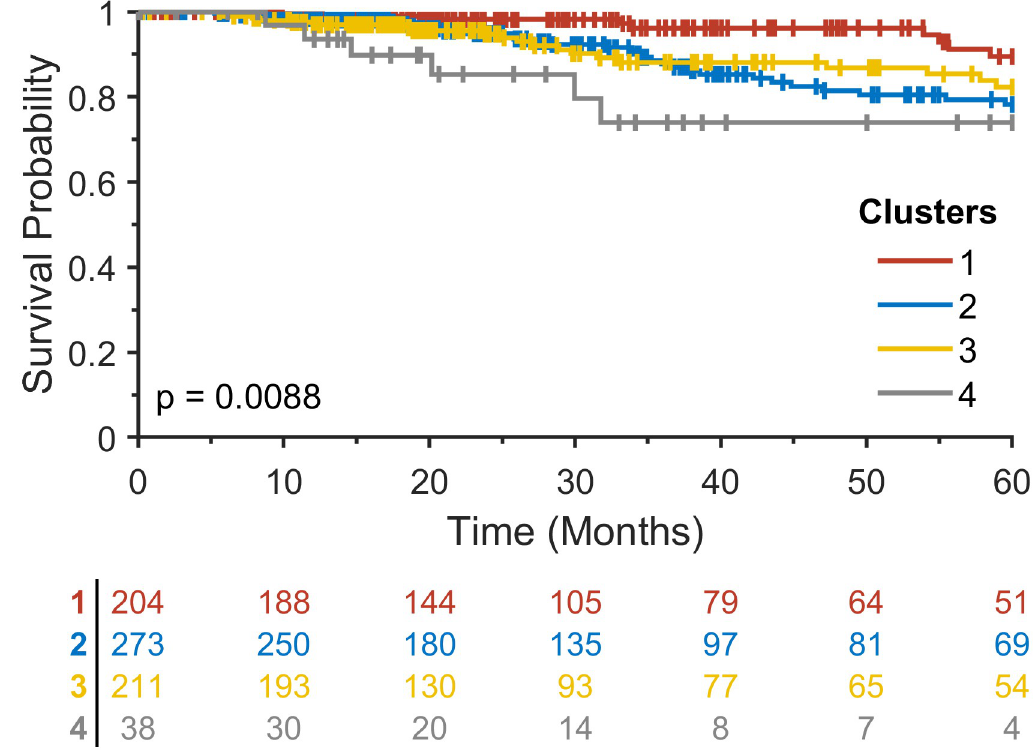
Fig 5. Kaplan-Meier analysis for four clusters that resulted from a hierarchical clustering method on the vector-valued Wasserstein distance matrix in the TCGA breast cancer